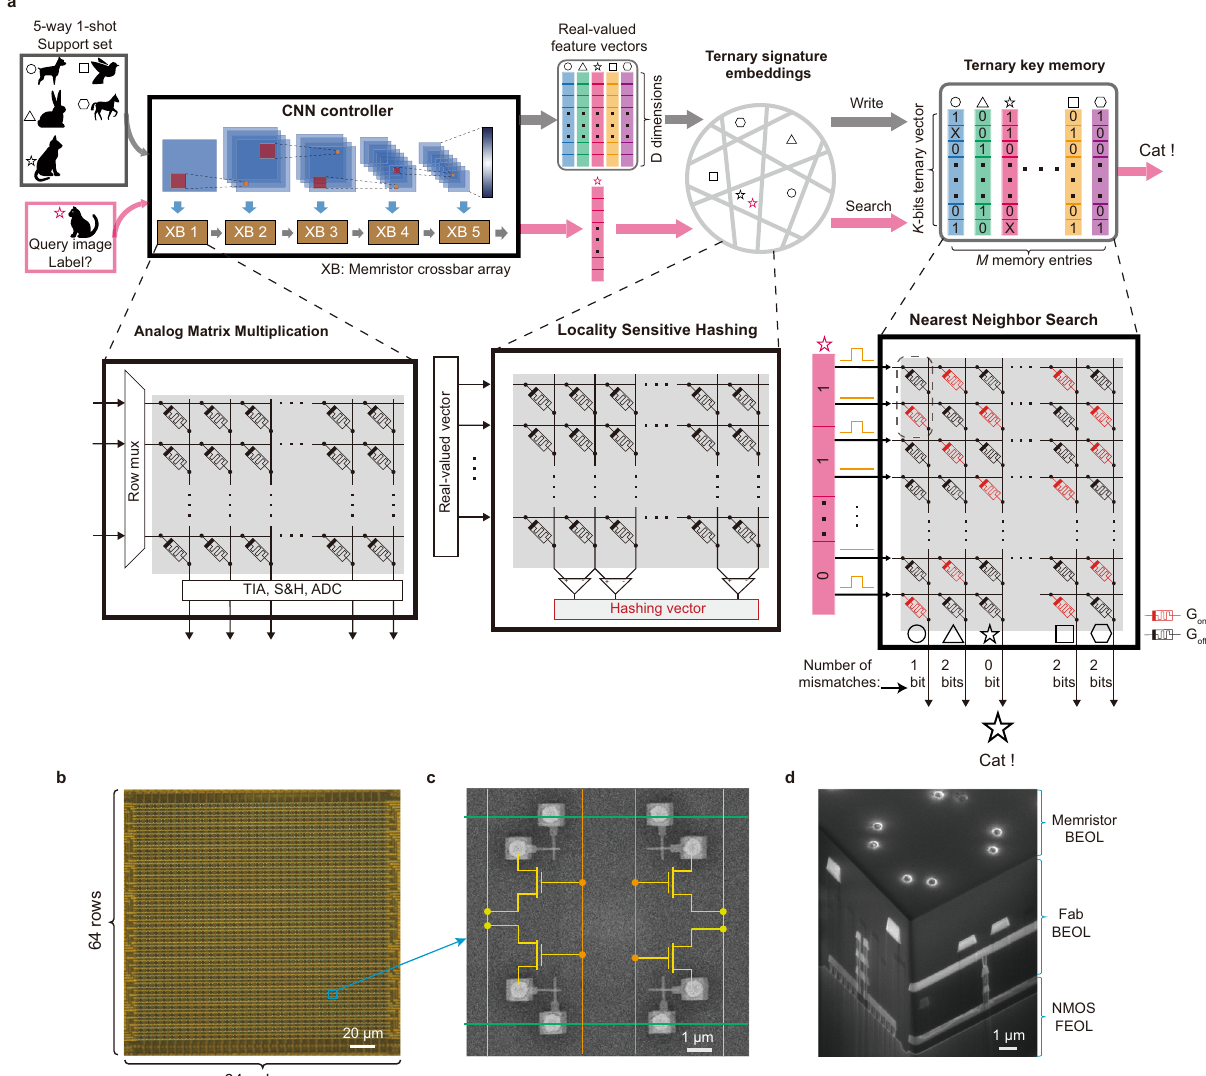
Fig.1|Memory-augmentedneuralnetworksincrossbararrays.a Theschematic of a crossbar-based MANN architecture. The expensive data transfer in a von Neumann architecture can be alleviated by performing analog matrix multi- plication, locality sensitive hashing, and nearest neighbor searching directly in memristorcrossbars,wherethedataisstored. b Opticalimageofa64×64crossbar